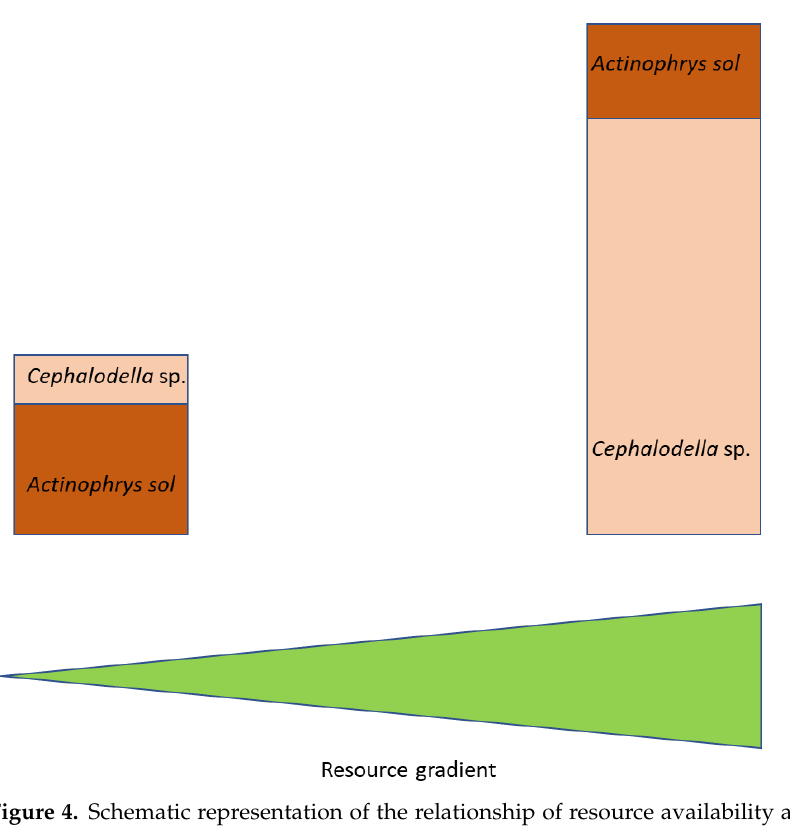
Figure 3. Relative contribution of Cephalodella sp. to total consumer abundance at varying produc- tivity levels. Data were combined from the micro-scale experiments (Micro-Expts) mean ± standard error, the meso-scale experiments (Meso-Expts) and field data for mean abundances over a three- year observation period (field data from [25]). Solid line, trend curve fit.